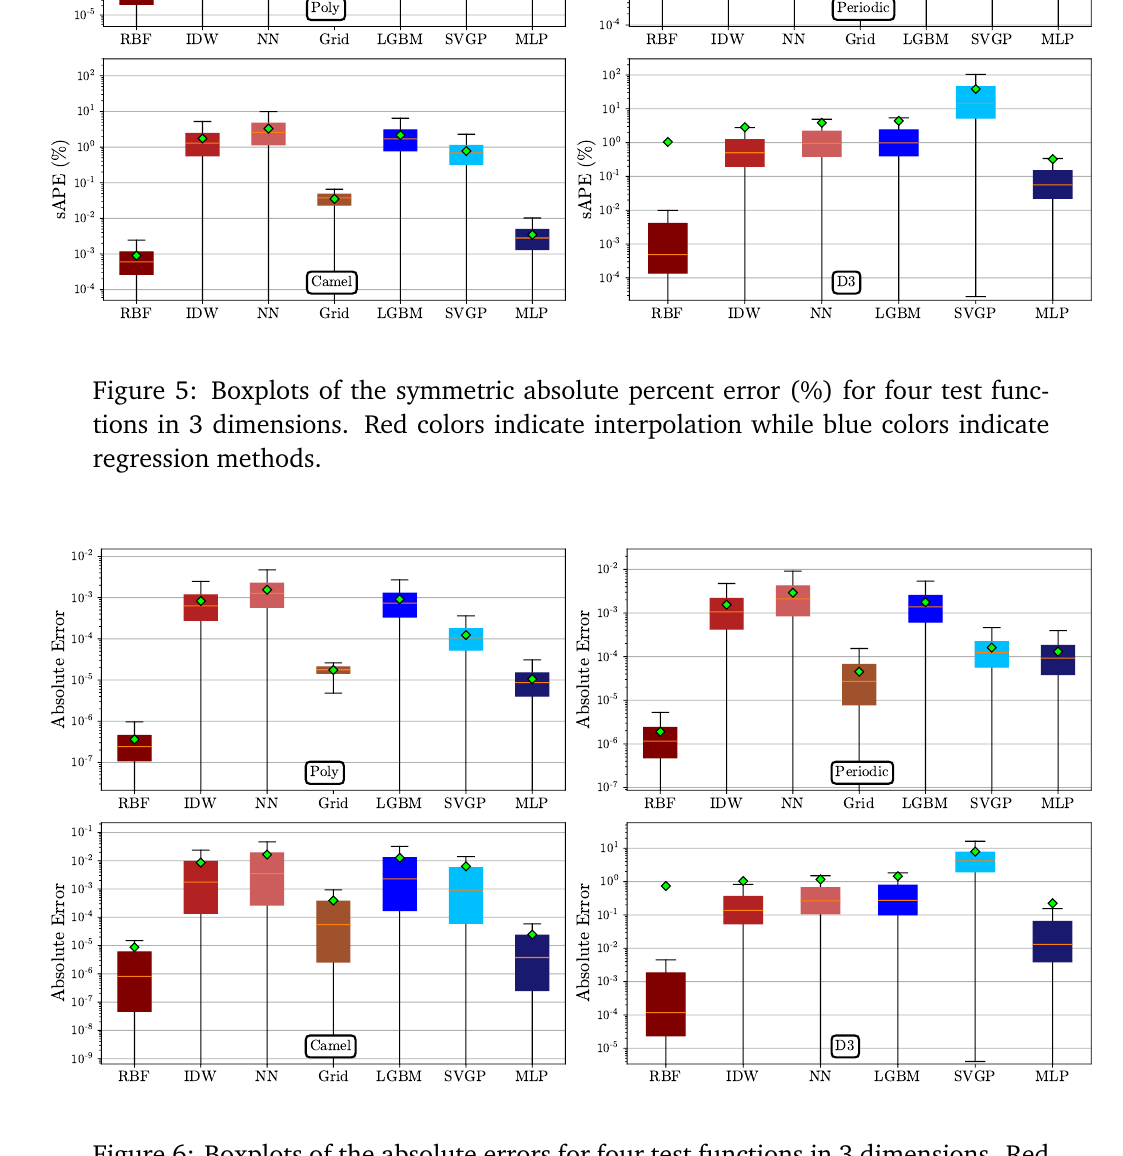
Figure 6: Boxplots of the absolute errors for four test functions in 3 dimensions. Red colors indicate interpolation while blue colors indicate regression